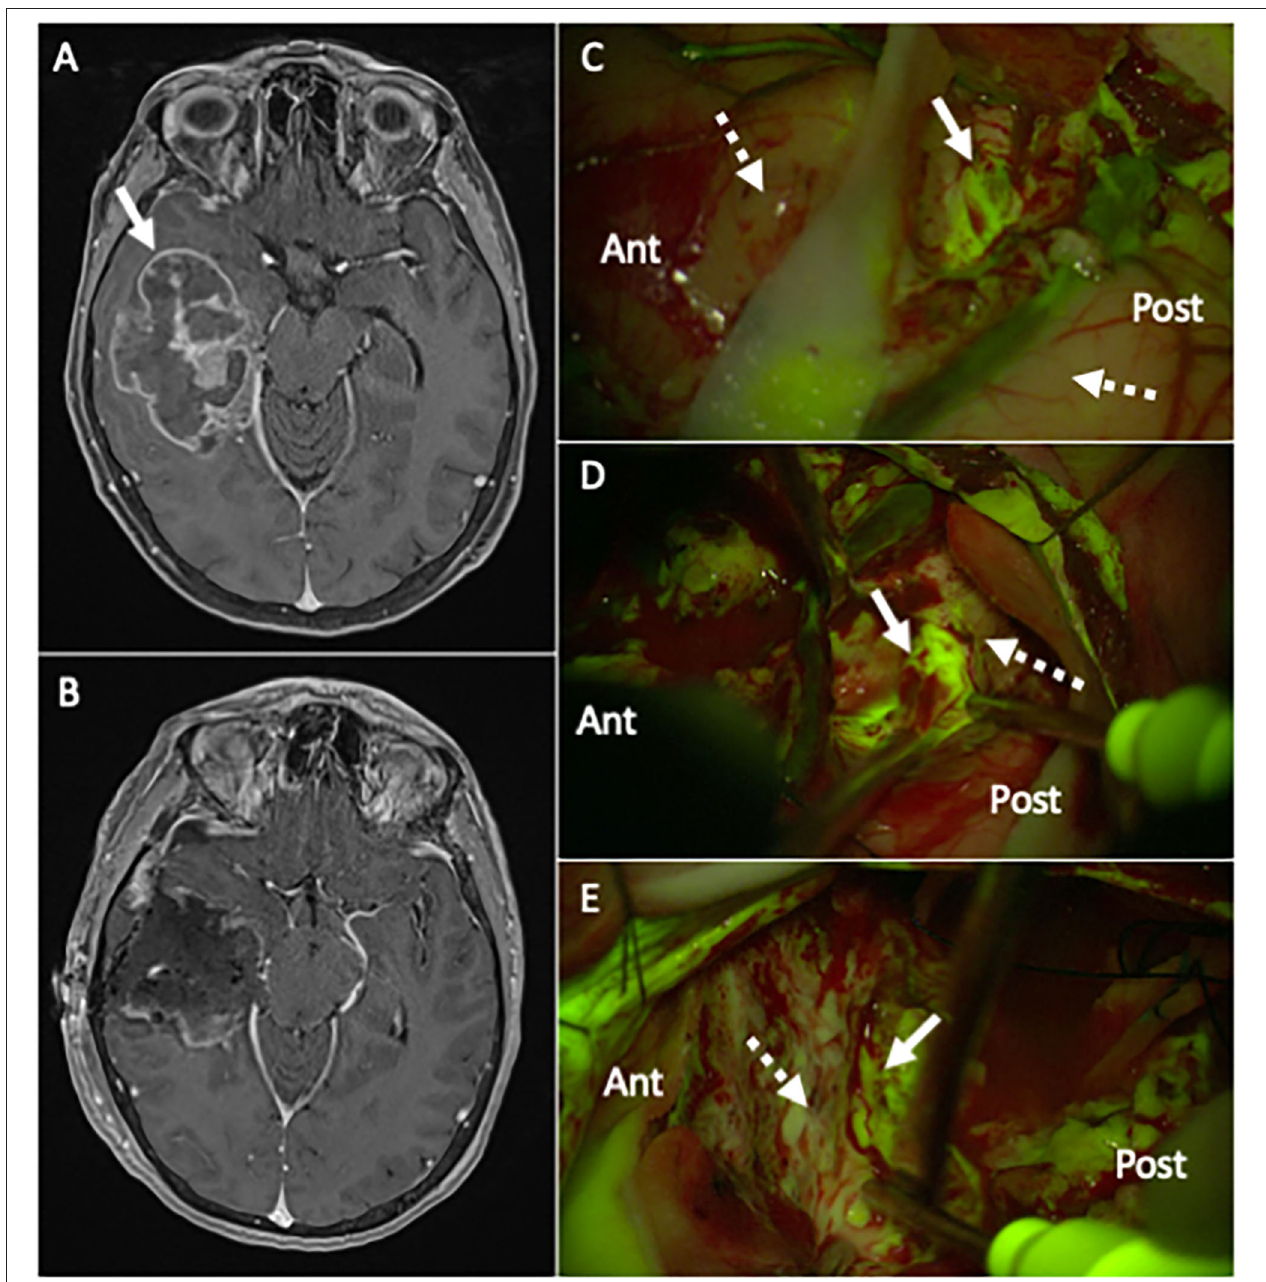
FIGURE 2 | (A) Pre-operative T1 post-contrast MR, showing a large right temporal lesion (white arrow), with irregular enhancement and mass effect, compatible with the suspect of high-grade glioma. (B) Post-operative T1 post-contrast MR, performed 24h after surgery, confirming a gross-total resection (GTR) of the lesion (histological diagnosis showed a Glioblastoma, IDH wild-type). (C–E) Intraoperative picture during the surgical removal of the same case depicted in (A) , taken with the Y560 filter activated (Pentero 900 microscope, Carl Zeiss Meditec, Oberkochen, Germany): after a small corticectomy (C) , the pathological tissue is clearly visible as a bright green-yellow fluorescent area (white arrow), while the non-pathological temporal cortex (dotted white arrow) anteriorly and posteriorly is non-fluorescent (for orientation, Ant is anterior and Post is posterior temporal lobe); during surgical removal with ultrasonic aspirator (Sonoca 300, Soring, Quickborn, Germany), subcortical tumoral tissue is clearly discernible from normal peri-tumoral parenchyma by its bright green-yellow fluorescence (white arrow in (D) at the posterior border and in (E) at the anterior border), compared to pinkish peritumoral parenchyma (dotted white arrow).